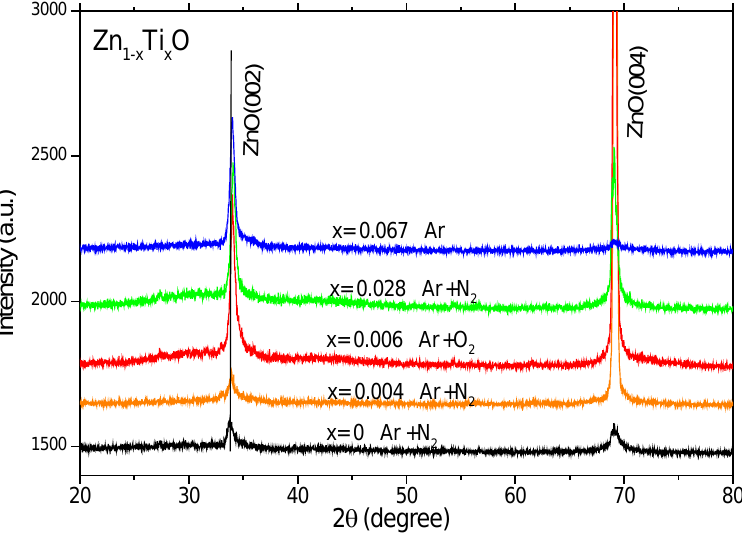
Ti O films deposited on Si(100). 1- x x